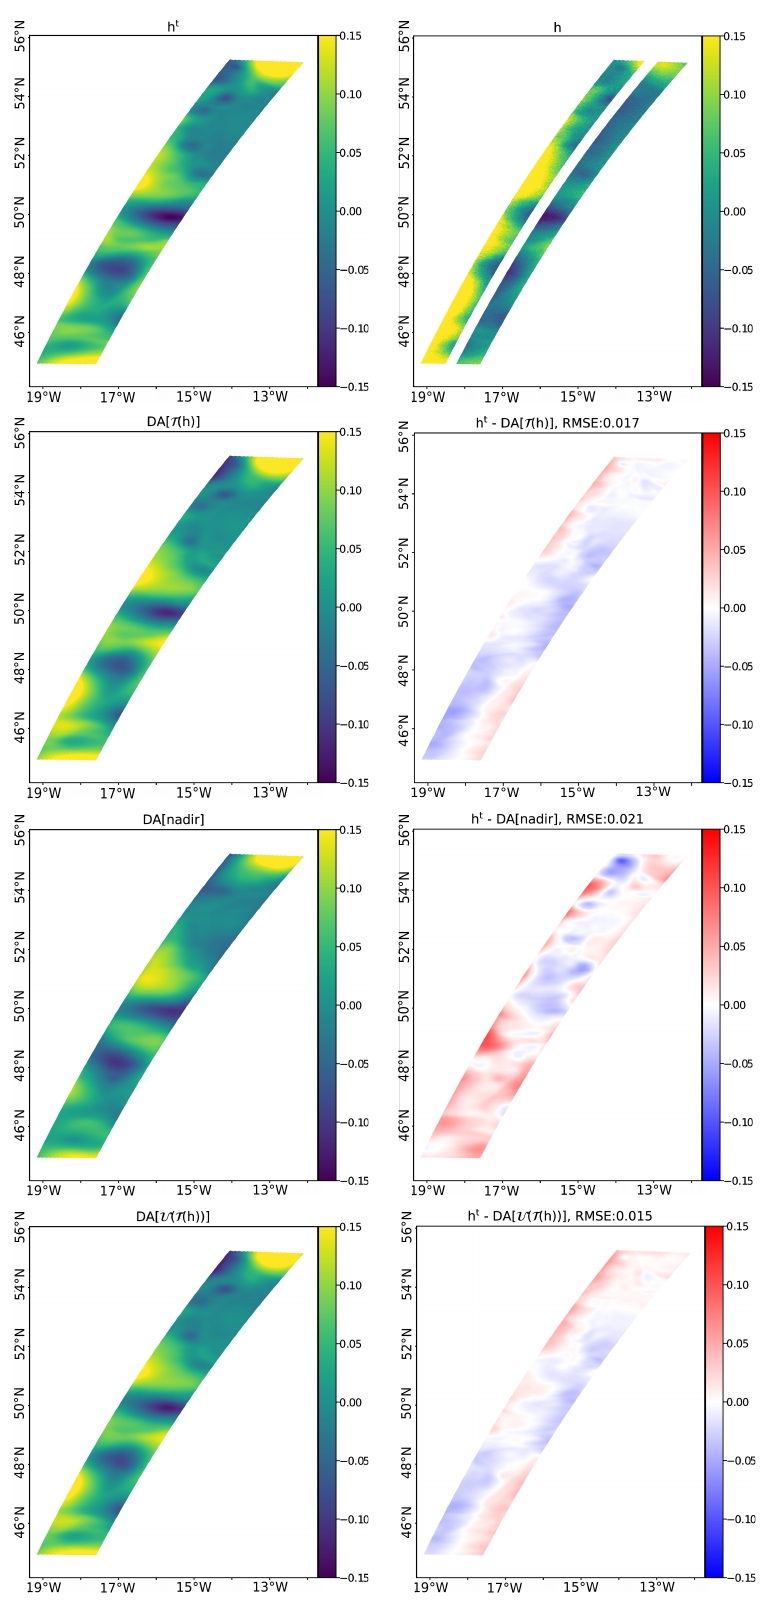
Figure 9. Same as Figure 6 but compares two additional results: DA[nadir] and DA[ U ( T ( h ))